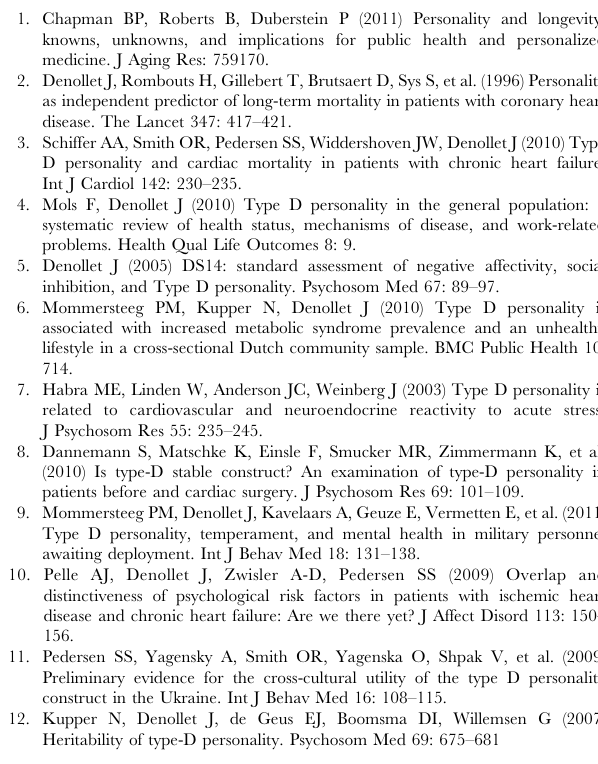
Table S1 Demographic characteristics for the 960 participants whose missing data was imputed,